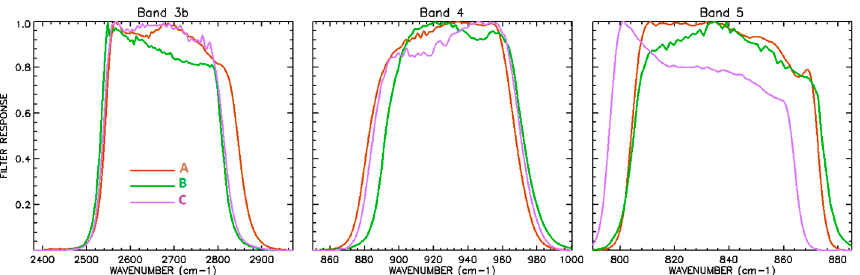
Figure 1. Spectral response functions (SRFs) of the (red) Metop-A, (green) Metop-B, and (blue) Metop-C in AVHRR thermal bands (left) 3b, (center) 4, and (right) 5 [35] .